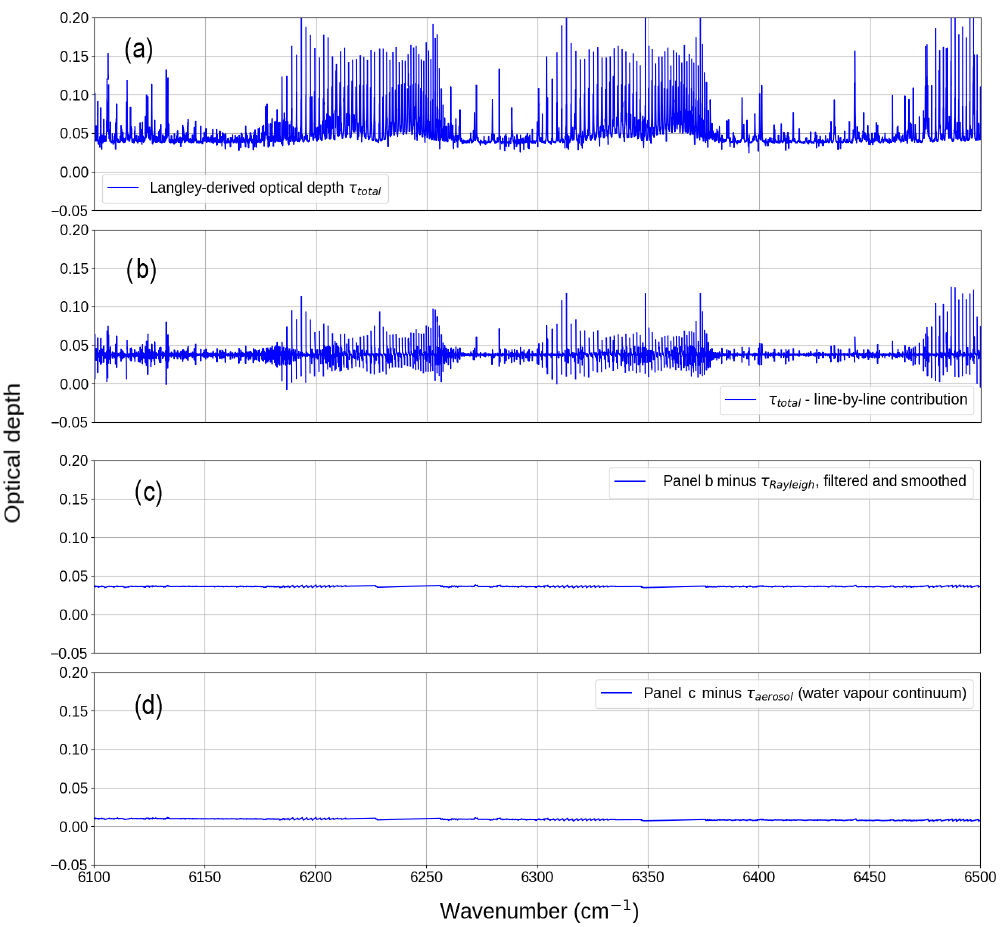
Figure 3. Example derivation of the water vapour continuum optical depth τ cont from the total optical depth τ total (a) via subtraction of τ H and τ other_gases (b) , smoothing and subtraction of Rayleigh scattering τ Rayleigh and continuum absorption by other gases τ other (c) , 2 O_lines and finally subtraction of τ aerosol to get the water vapour continuum optical depth (d)